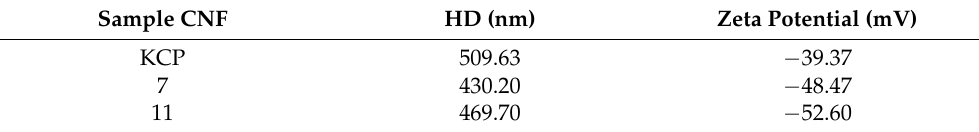
Table 2. Averages hydrodynamic diameter and zeta potential of KCP and two CNF